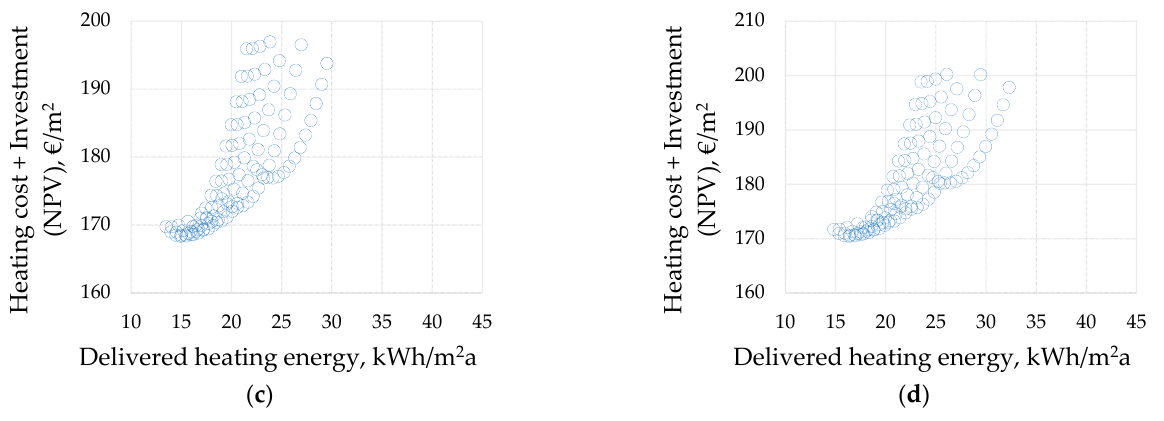
Figure 7. Cost optimal solution of a whole building model based on heating energy-related cost and investment cost for different climates ( a ) Tallinn, ( b ) Sapporo, ( c ) Paris, and ( d ) Brussels.